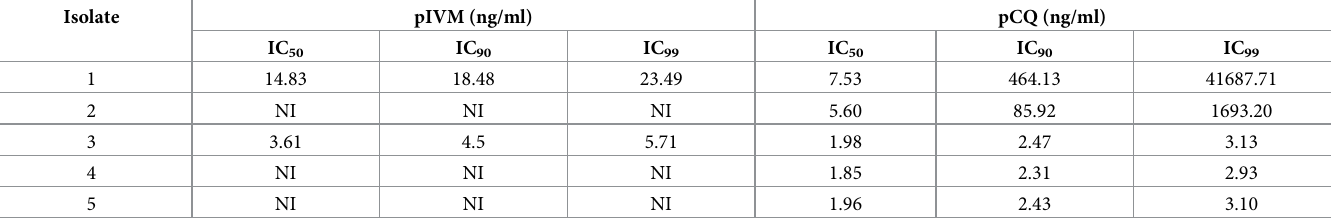
Table 1. Exvivo activity of ivermectin and chloroquine against P . vivax isolates from Manaus- AM, Brazil.